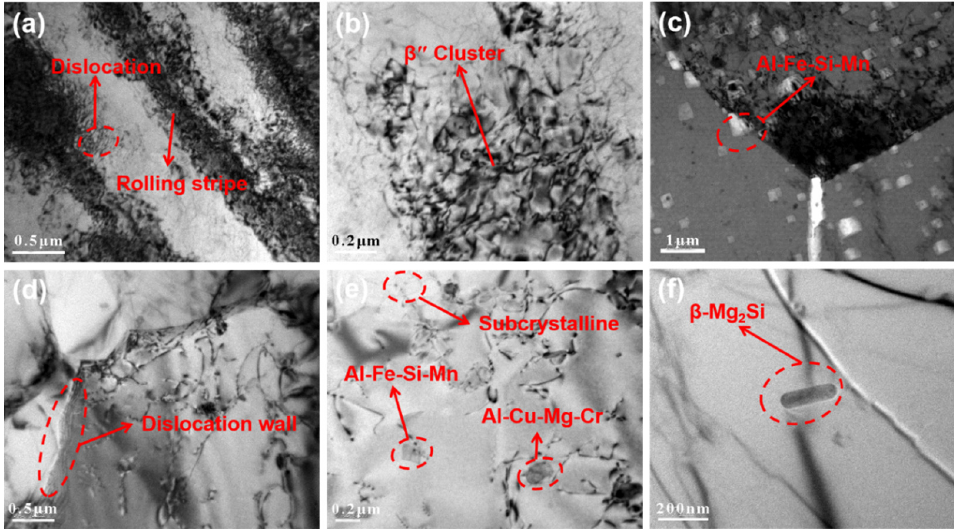
Figure 8. Transmission electron microscope of the BM and NZ, ( a , b ) BM, ( c ) NZ at 6000 rpm, ( d – f ) NZ at 12,000 rpm.